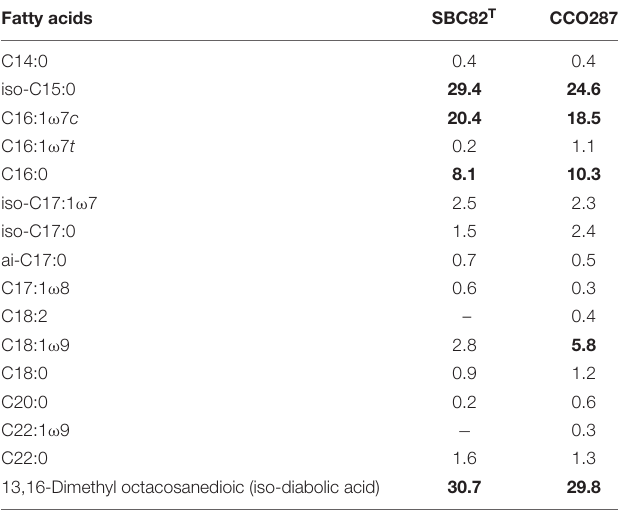
TABLE 2 | Fatty acid composition (%) released after acid hydrolysis of cell material of strains SBC82 T and CCO287. Fatty acids SBC82 T